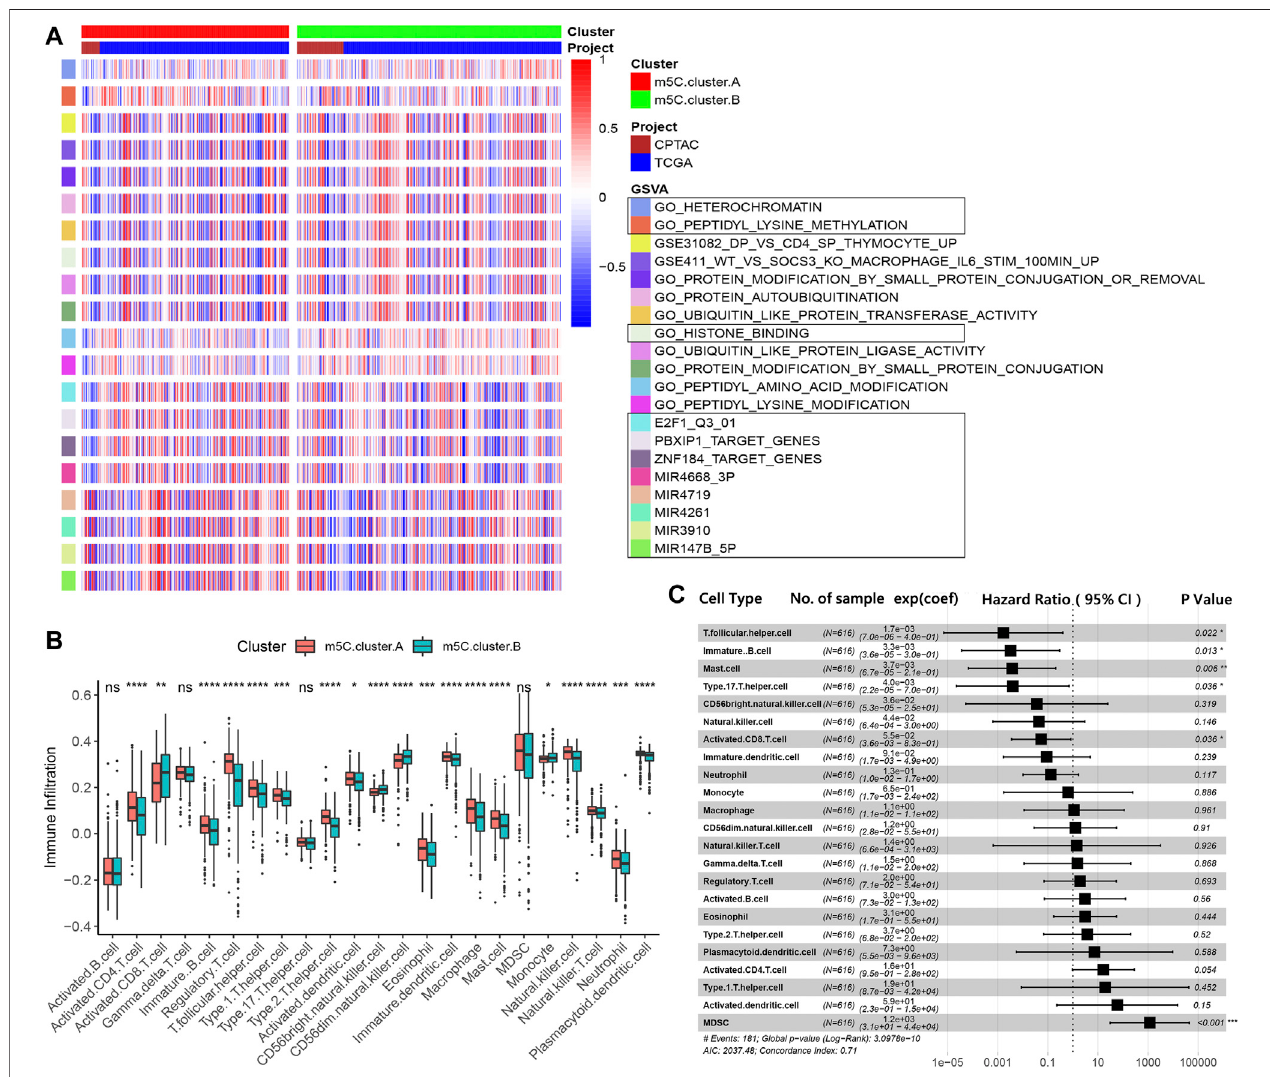
FIGURE 3 | TME characterizations and in fi ltrating immune cells in the two m 5 C modi fi cation patterns. (A) GSVA results of the two m 5 C modi fi cation patterns. (B) Estimation of immune cell in fi ltration in the two m 5 C modi fi cation patterns. (C) Univariate regression analysis of various types of immune cells.